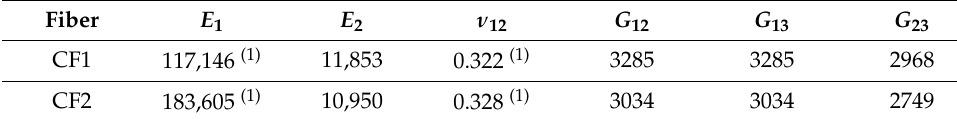
Table 5. Orthotropic elastic properties of laminae.